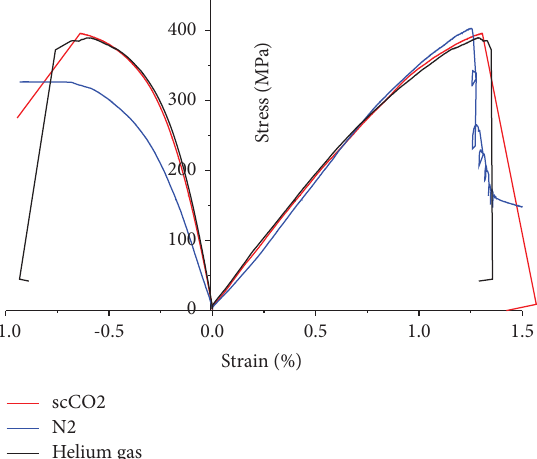
Figure 4: Te relationship between triaxial strength and coring angle.